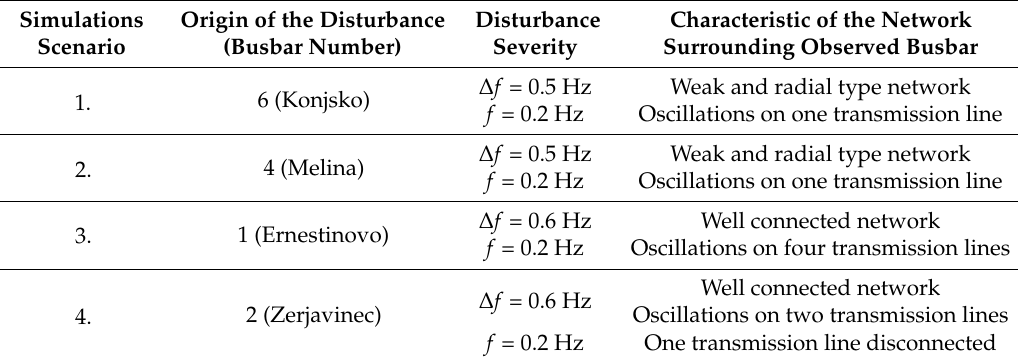
Table 3. Scenarios for out-of-step condition